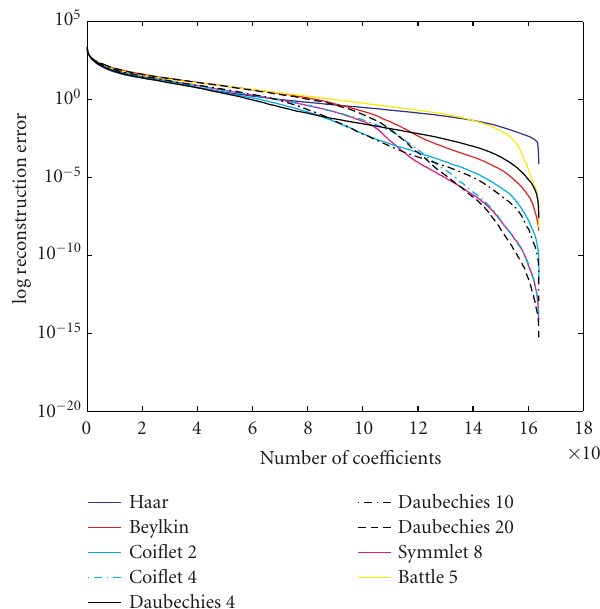
Figure 4: Decay of wavelet coe ffi cients of real part on a semilog scale for various wavelets and vanishing moments.